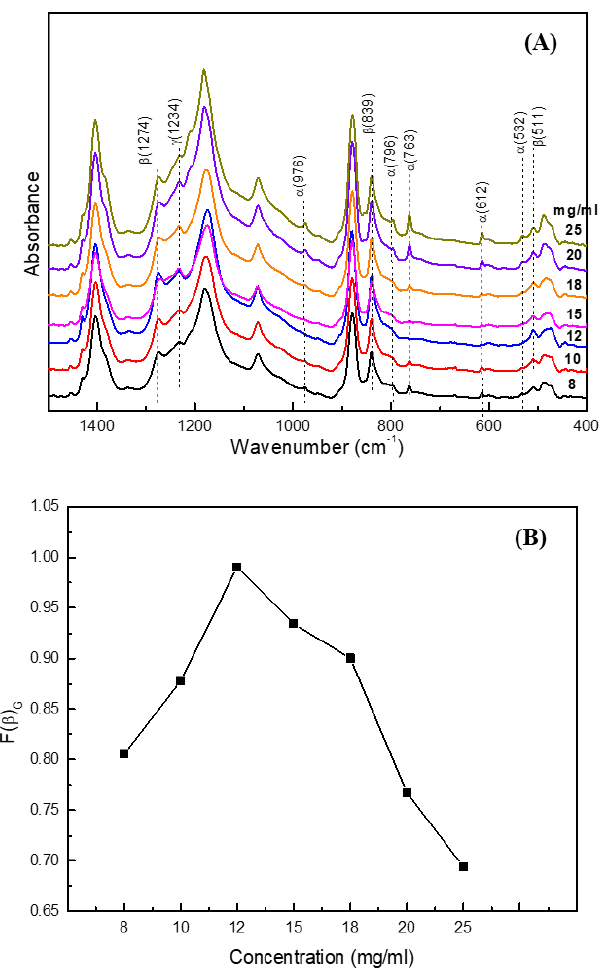
Figure 7. ( A ) FTIR spectra of ultrasonic spray-coated PVDF films and ( B ) the solution concentration-dependent relative fraction of β-form crystal (F(β) G ).